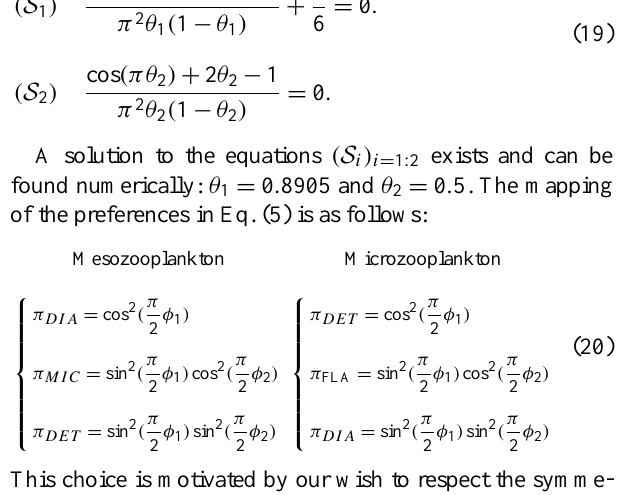
Fig. 1. Reference solution: time evolution of chlorophyll and nitrate in the upper 100m from 1 January 2000 to 31 December 2004.